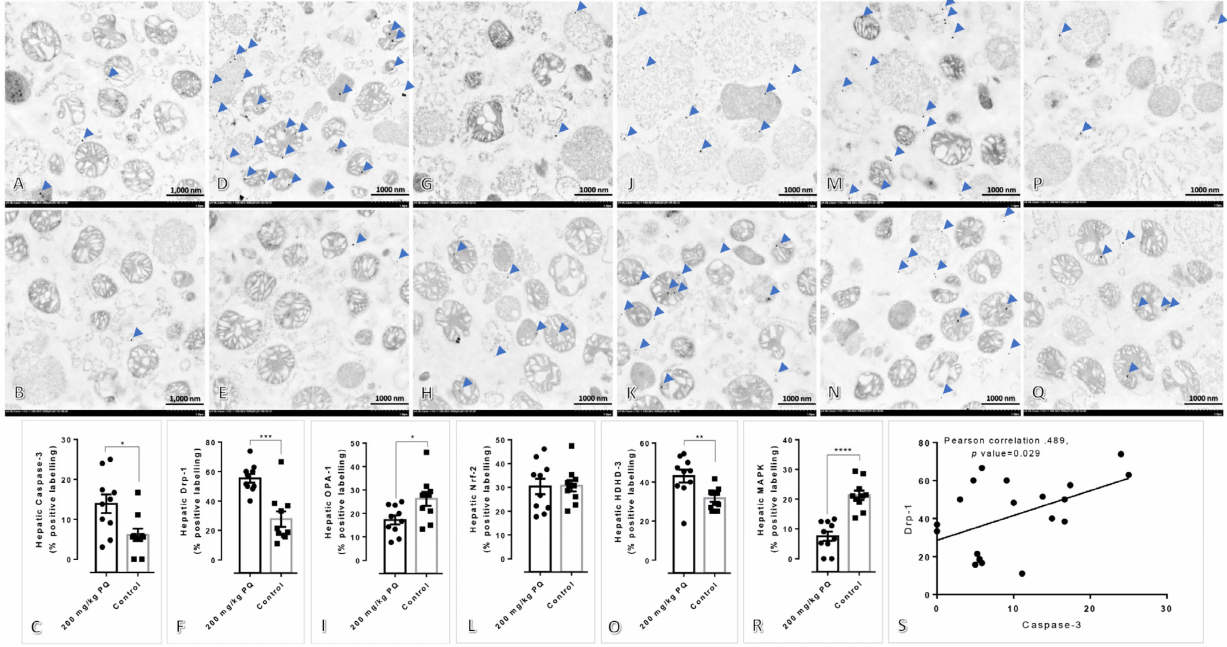
Figure 4. Immunogold labeling of caspase-3, Drp-1, OPA-1, Nrf-2, HDHD-3, and MAPK in hepatic mitochondria after treated with or without 200 mg/kg of PQ: ( A , D , G , J , M , P ) Hepatic mitochondrial architecture in rats treated with 200 mg/kg of PQ; ( B , E , H , K , N , O ) Hepatic mitochondrial architecture in non-treated rats; ( A – R ) Immunogold labeling of caspase-3, Drp-1, OPA-1, Nrf-2, HDHD-3, and MAPK in rats treated with or without 200 mg/kg of PQ, respectively. ( S ) Spearman’s correlation test between the level of Drp-1 and caspase-3 in the hepatic mitochondria of rats treated or non-treated with 200 mg/kg of PQ. The statistical significance of comparisons for subsequent figures is *, p < 0.05; **, p < 0.01; ***, p < 0.0001; and ****, p <